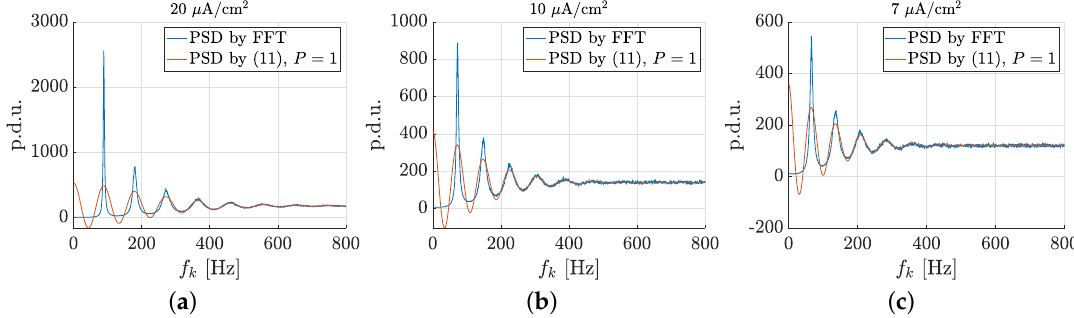
Figure 5. Prediction of frequencies of power spectra peaks with µ 1 (red solid line). Panels ( a – c ) report, respectively, power spectra for I 0 = (20, 10, 7) µA/cm 2 , patch = 100 µm 2 .